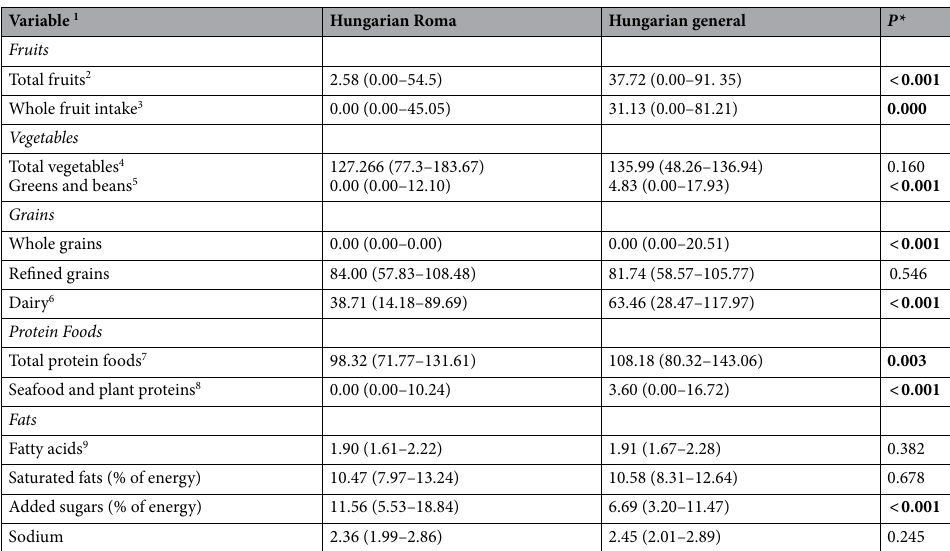
Table 2. Food and nutrient intake used for Healthy Eating Index-2015 component scores. 1 Data represent average daily intake amounts in grams per 1000 kcal energy intake except in the cases indicated. Values are medians (25th–75th percentiles). 2 Includes 100% fruit juice. 3 all forms except juice. 4 Includes legumes (beans and peas). 5 Includes legumes and dark-green leafy vegetables. 6 Includes all milk products, such as fluid milk, yogurt, cheese, and fortified soy beverages. 7 Includes meat, poultry, seafood, beans and peas, eggs, and nuts and seeds. 8 Includes seafood, nuts, seeds, soy products (other than beverages), and legumes (beans and peas). 9 Ratio of poly-and mono-unsaturated fatty acids (PUFAs and MUFAs) to saturated fatty acids (SFAs). *Differences in the distribution of intakes were evaluated by Independent-Samples Mann–Whitney U test. Bold values represent significant differences.